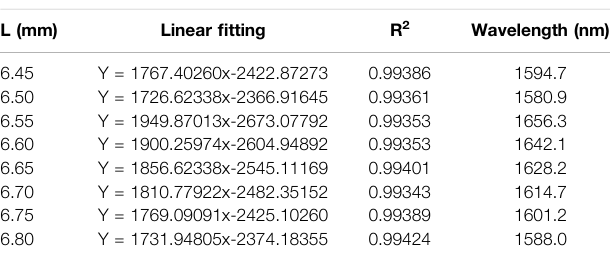
TABLE 2 | Linear fi tting of wavelength shift at 1,500 – 1,700